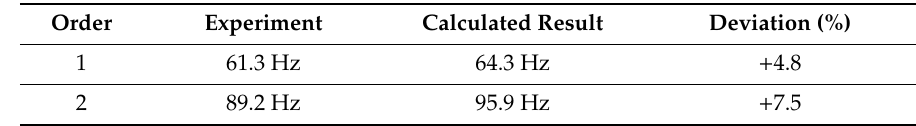
Table 8. The comparison